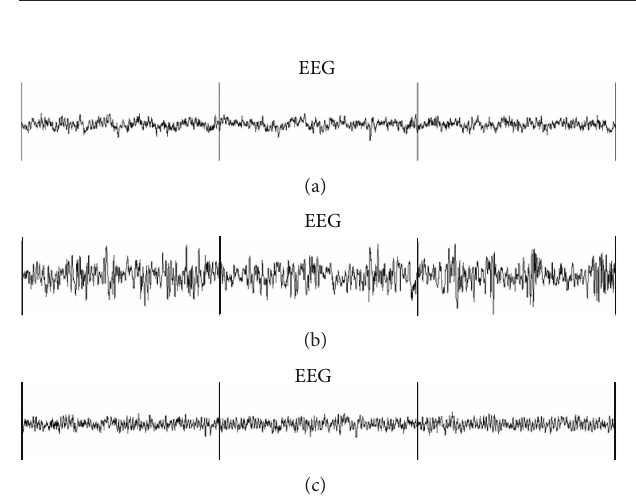
Figure 1: EEG patterns during different stages of sleep in three 10- second epochs of a normal rat: (a) wake, (b) NREM sleep, and (c) REM sleep.